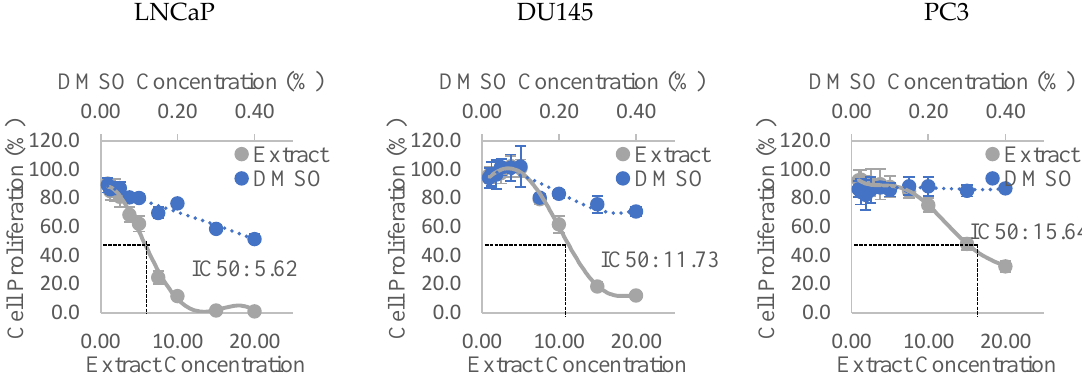
Figure 1. Dose-response curves of prostate cancer cell lines treated with the hexane extract of Olga’s Round Golden Chicken Egg tomato. Values are Mean ± Pooled SD; DMSO: Dimethyl sulfoxide; Extract concentrations and IC50 are expressed in mg dry tomato equivalent/mL.